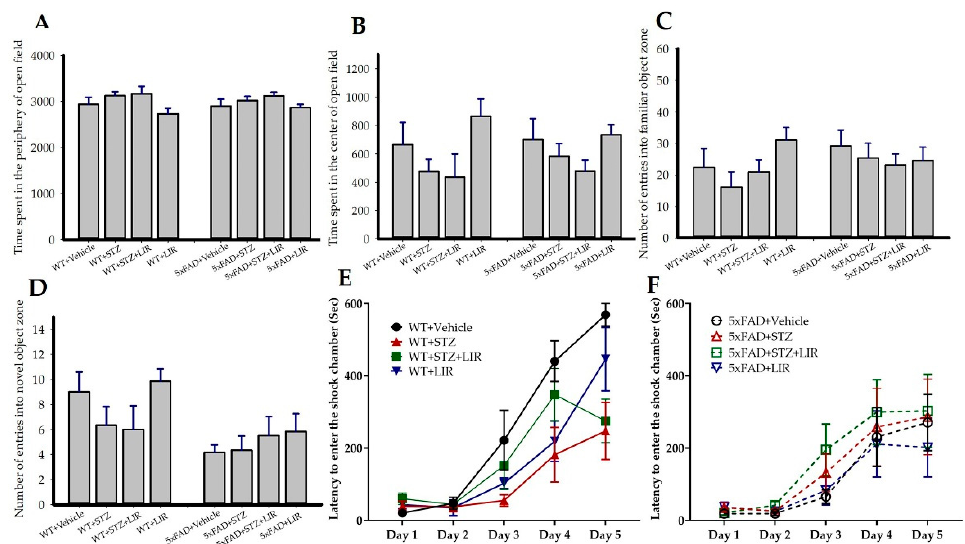
Figure 1. Behavioral analyses in sporadic AD model and 5xFAD mice after treatment with liraglutide: After 30 days of LIR treatment, the mice in both SAD and 5xFAD mouse models were subjected to a series of behavioral tests. Open-field (OF) task was used to assess spontaneous motor activities, exploratory behaviors were assessed through novel object recognition (NOR) task, and the differences in learning and memory were assessed through passive avoidance (PA) task. There were no significant between-group differences in the total time spent in the periphery ( A ) and in the center ( B ) of the open-field task over 60 min and in the number of entries into the familiar-object (FO; ( C )) and novel-object (NO; ( D) ) zone in the NOR task. To test the differences in learning and memory on PA task, the ability of the mice to avoid an aversive stimulus, as measured in latency to enter the shock chamber, was analyzed by repeated-measures ANOVA. There were no significant between-group differences in the latency to avoid the shock in all trials between SAD and 5xFAD mouse models (( E , F ), respectively). Data from n = 6 animals from each group were expressed as mean ± SEM.